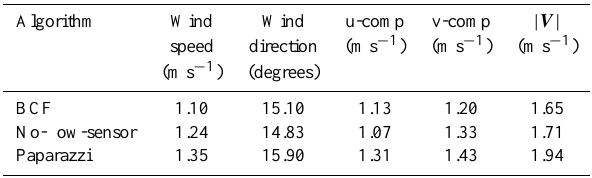
Table 1. Root mean squared errors (RMSE) for algorithms com- pared to rawinsonde observations for all flights within 1h of rawin- sonde launch time at heights above